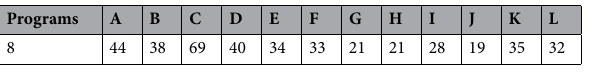
Table 8. Program 8 Duration of each